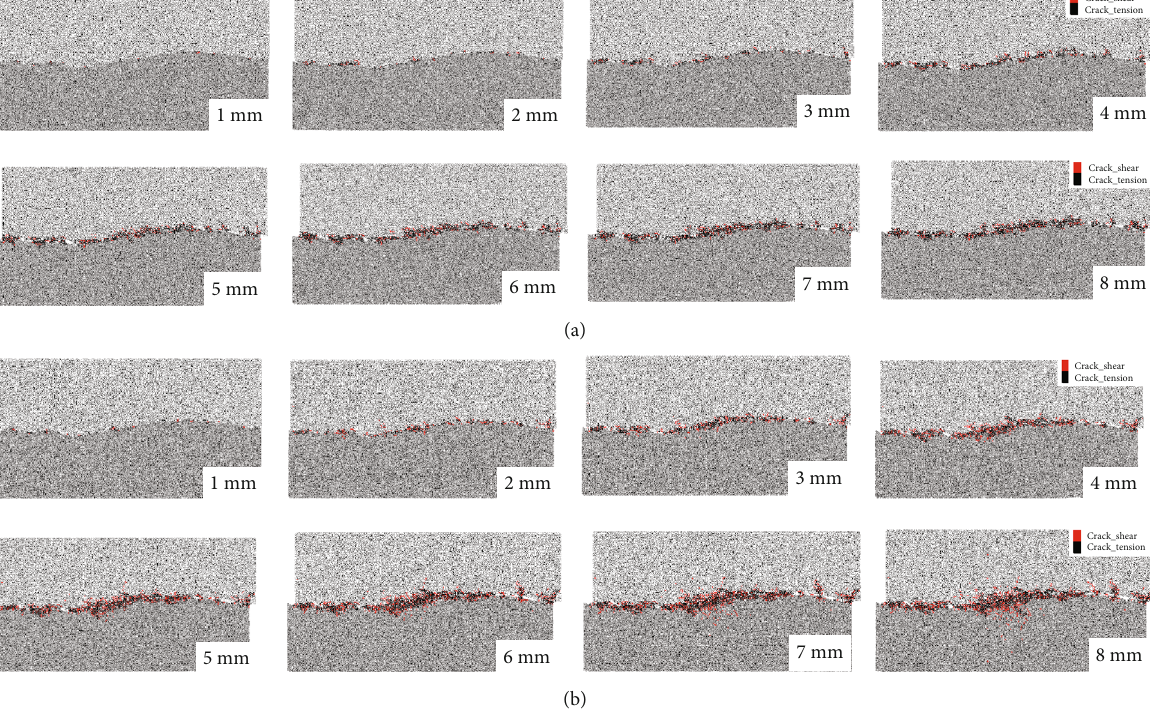
Figure 9: Evolution of microcracks during shearing: (a) low-strength rock joints; (b) high-strength rock